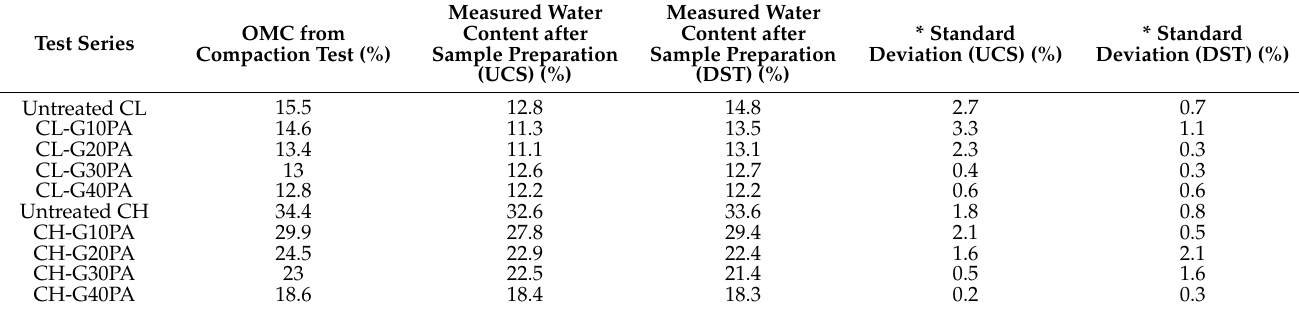
Table 4. Calculated moisture content (%) after unconfined compression (UCS) and direct shear test (DST) samples preparation. Measured Water Measured Water OMC from Content after Content after Test Series Compaction Test (%) Sample Preparation Sample Preparation (UCS) (%) (DST) (%) Untreated